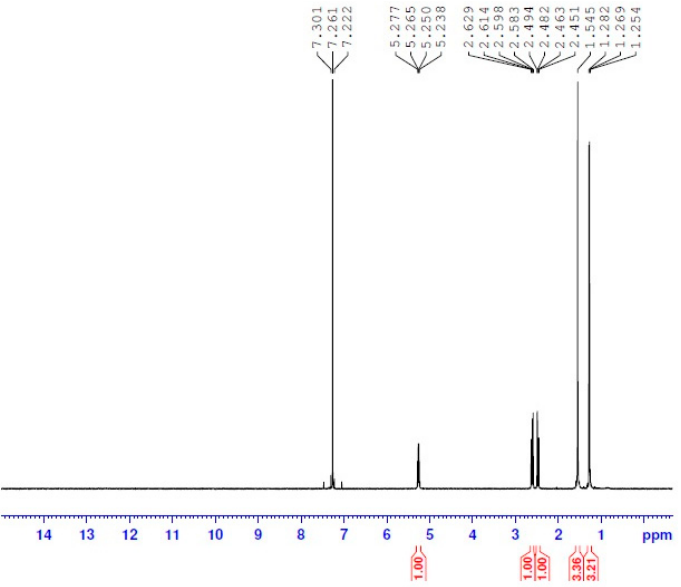
Figure 6. 1 H Nuclear Magnetic Resonance (NMR) spectrum of biopolymer obtained from co-culture of Sde 2-40 and B. Cereus .